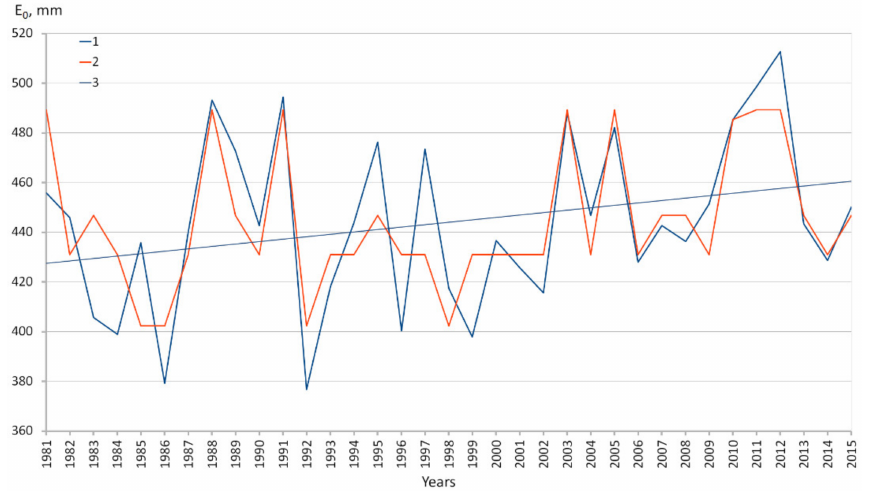
Figure 4. Comparison of the actual (1) (with linear trend (3)) and calculated by the decision trees model (2) annual values of potential evapotranspiration of the Ob’s basin for 1981–2015.